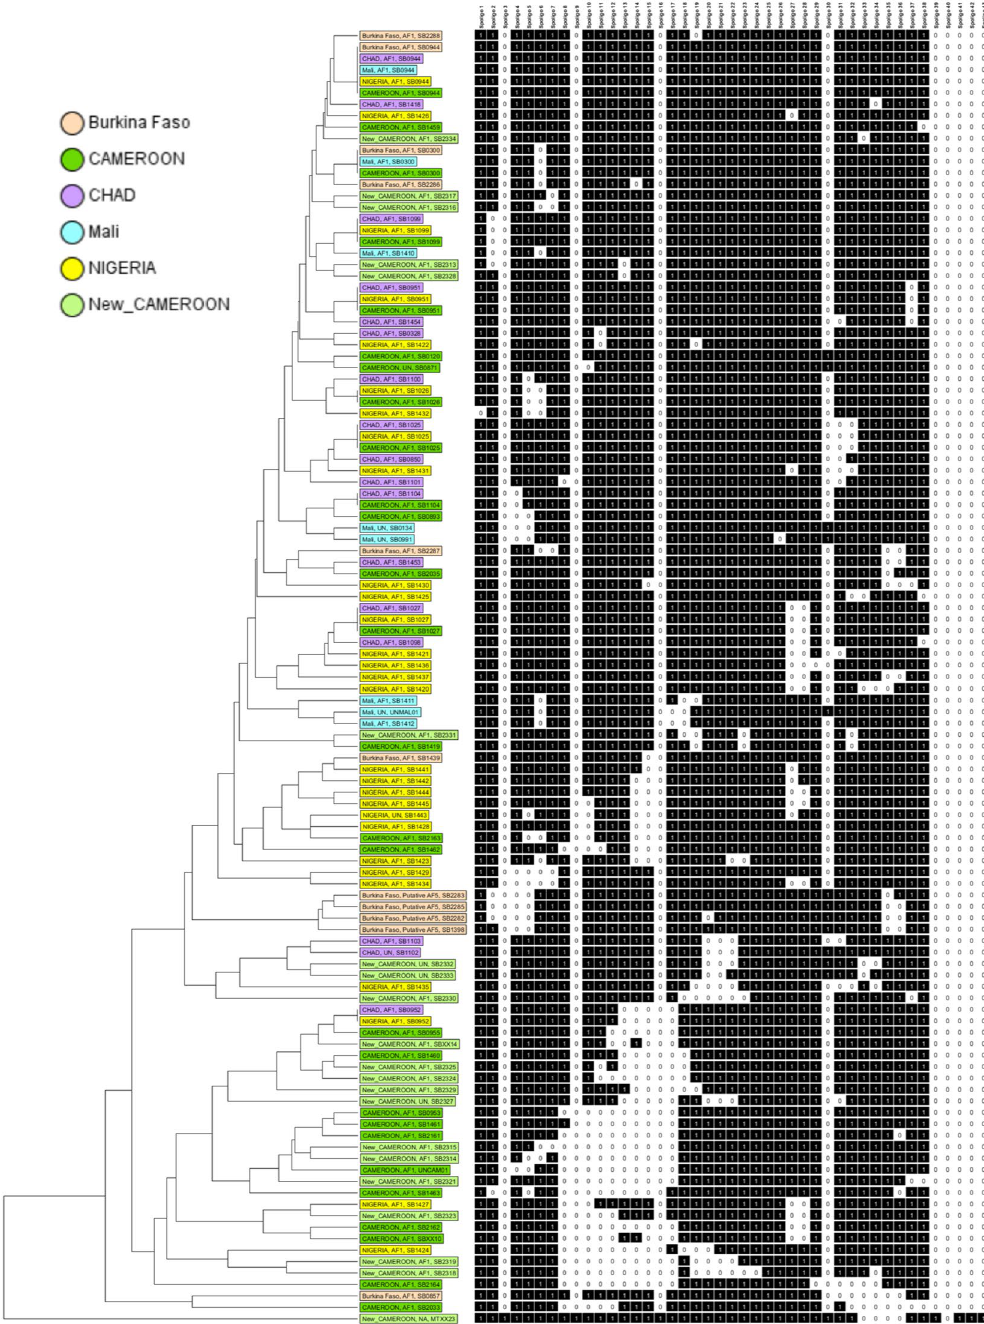
Figure 3. A UPGMA phylogenetic tree showing the unique historic spoligotypes reported in Central and West Africa along with the new previously unreported spoligotypes isolated from cattle from the four abattoirs sampled in Cameroon between 2012-1013. The tree is based on the standard 43 spoligotype